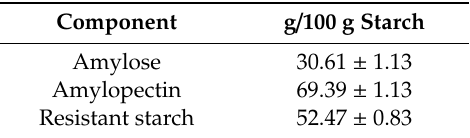
Table 2. Composition of teosinte flour starch.